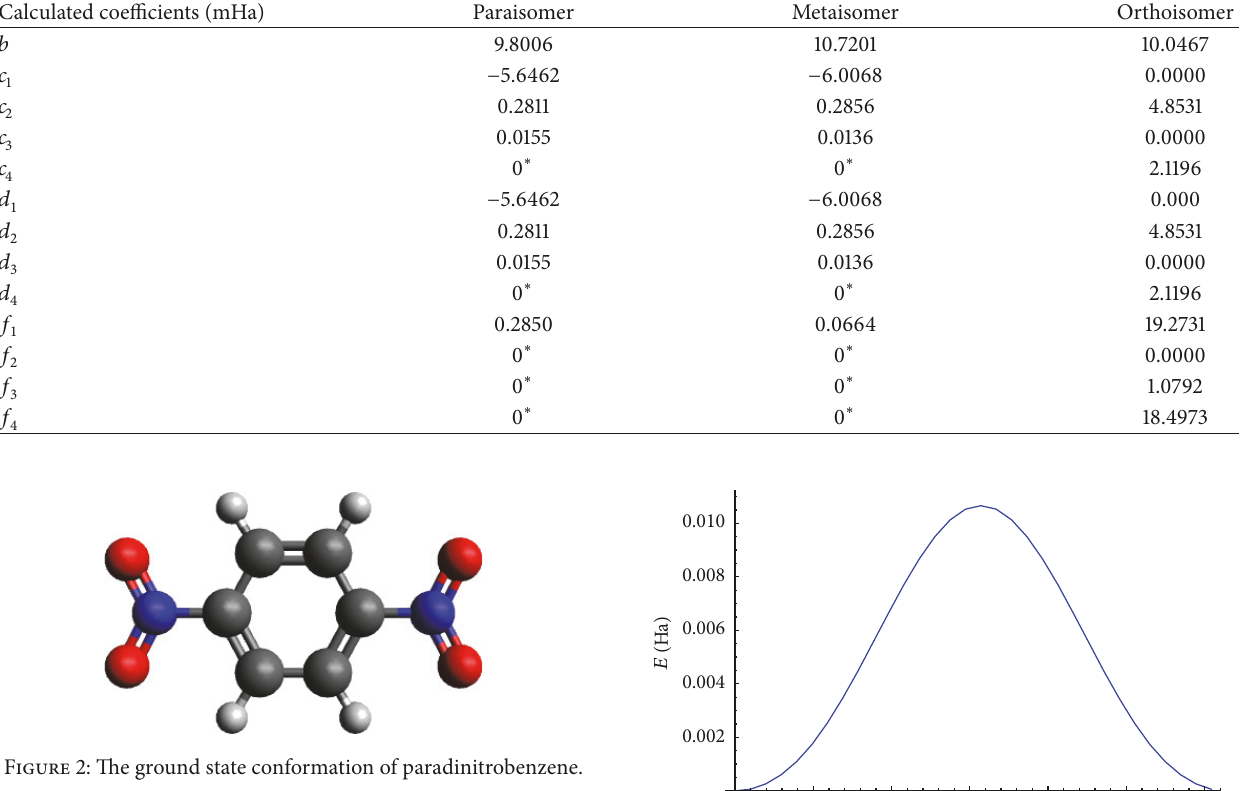
Table 1: Coefficients of the Legendre polynomial expansion. For each expansion, we truncate the polynomials once data at the lower energies fit well. The terms marked with “ ∗ ” are zero because of symmetries in the PES or are not used in the model because sufficient agreement was obtained with lower-order terms.